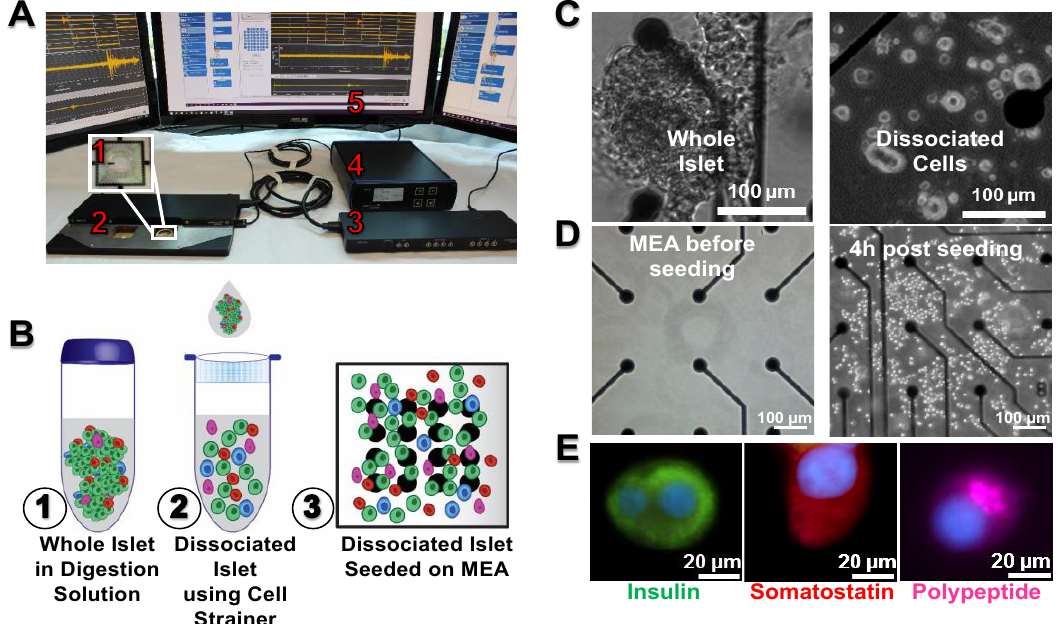
Figure 1. Dissociated islets on a microelectrode array (MEA). ( A ) MEA system setup contains five components; an MEA chip (A1), a two head-stages of MEA2100 system (A2), an interface board (A3), a temperature controller (A4), and a computer (A5). ( B ) Schematic illustration of clusters of whole islets in digestion solution (B1) dissociated into separated islets using a 40 µm cell strainer (B2), and finally seeding these dissociated islets on MEA coated with collagen IV (B3). ( C ) Bright field images of whole islet and dissociated islets on MEA. ( D ) Bright field images of MEA before seeding, and after four hours of seeding the dissociated islets. ( E ) Fluorescent images on day 7 for dissociated islets on glass coverslip showing successful separation of different cell population within the islet. Green color represents insulin (indicating β-cells), red color represents somatostatin (indicating δ-cells), magenta color represents pancreatic polypeptide (indicating γ-cells), and blue color represents DNA (indicating the cell nucleus).